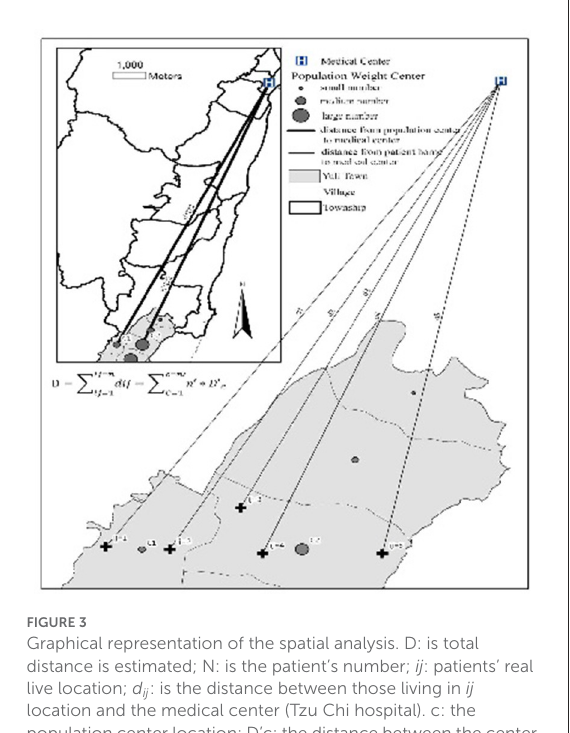
FIGURE3 Graphical representation of the spatial analysis. D: is total distance is estimated; N: is the patient’s number; ij : patients’ real live location; d ij : is the distance between those living in ij location and the medical center (Tzu Chi hospital). c: the population center location; D’c: the distance between the center of the population and the medical center (Tzu Chi hospital).